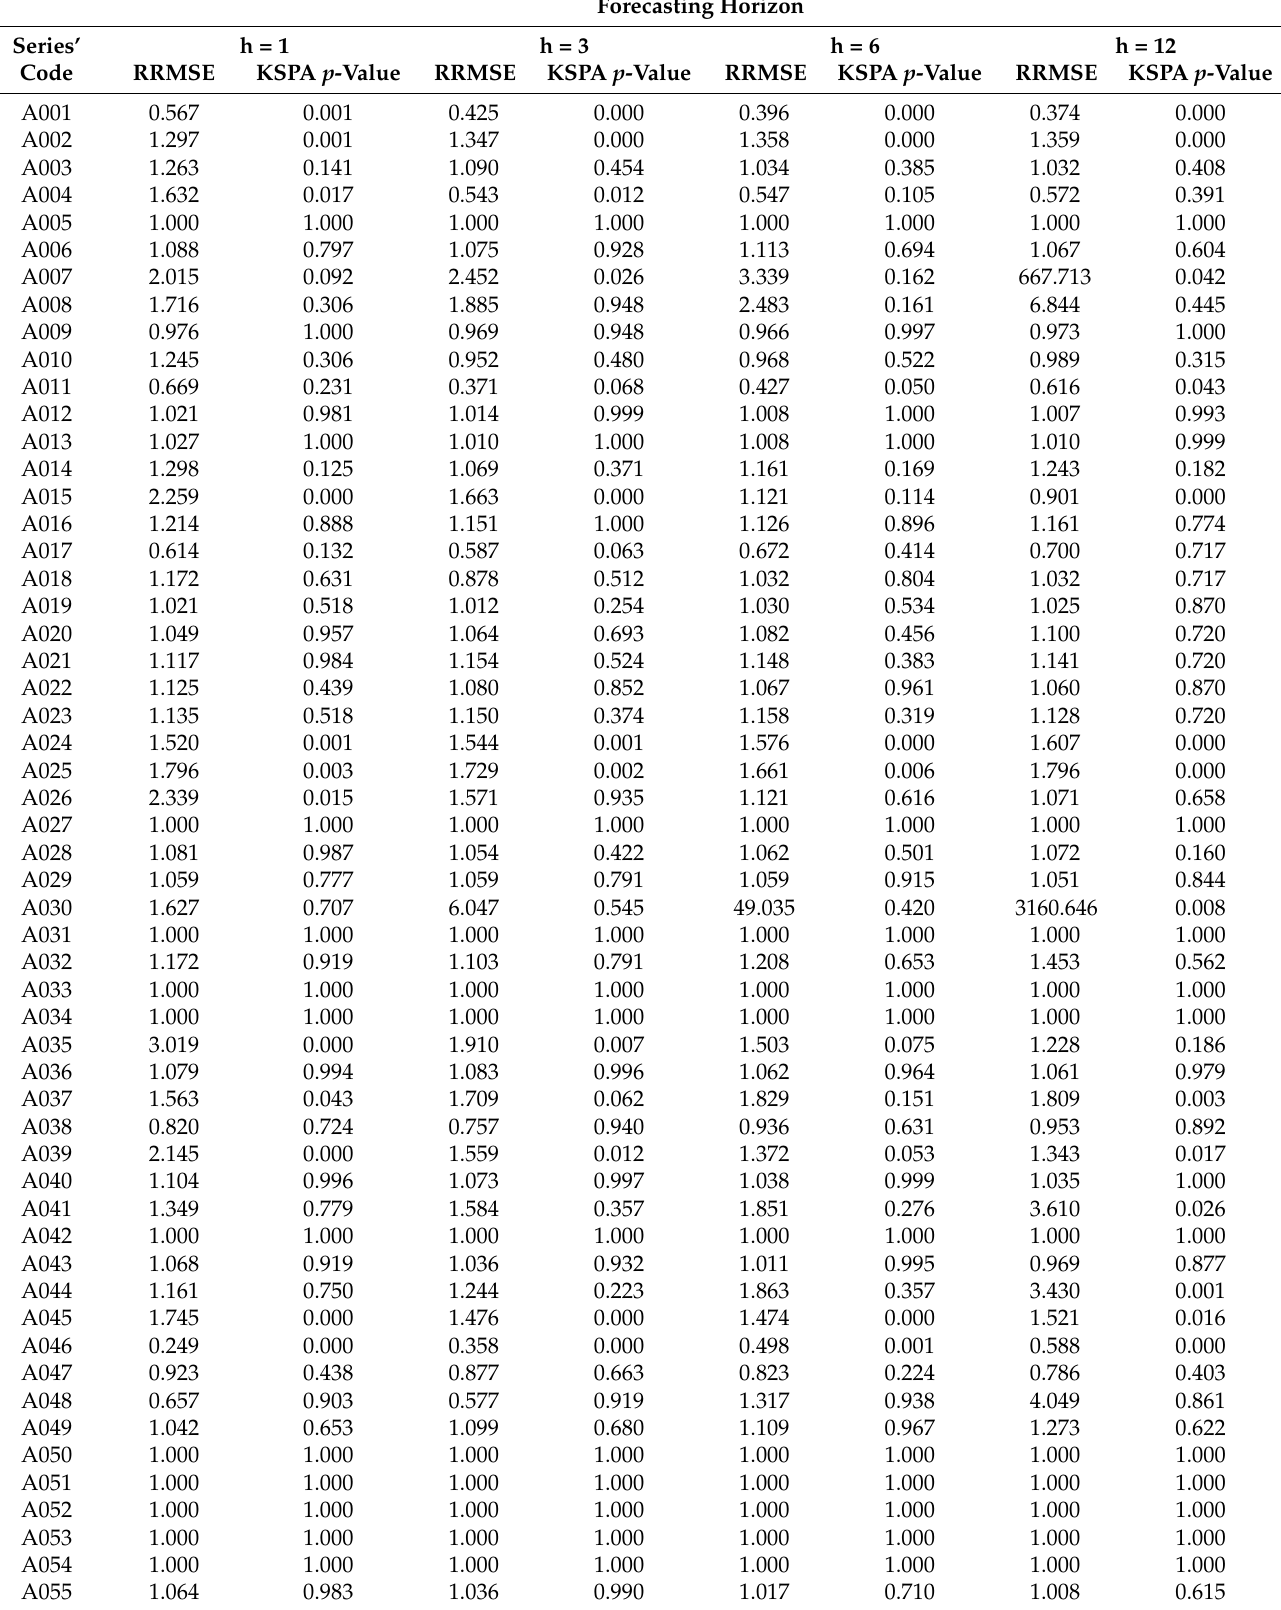
Table A3. RRMSEs and KSPA p -values for the 100 time